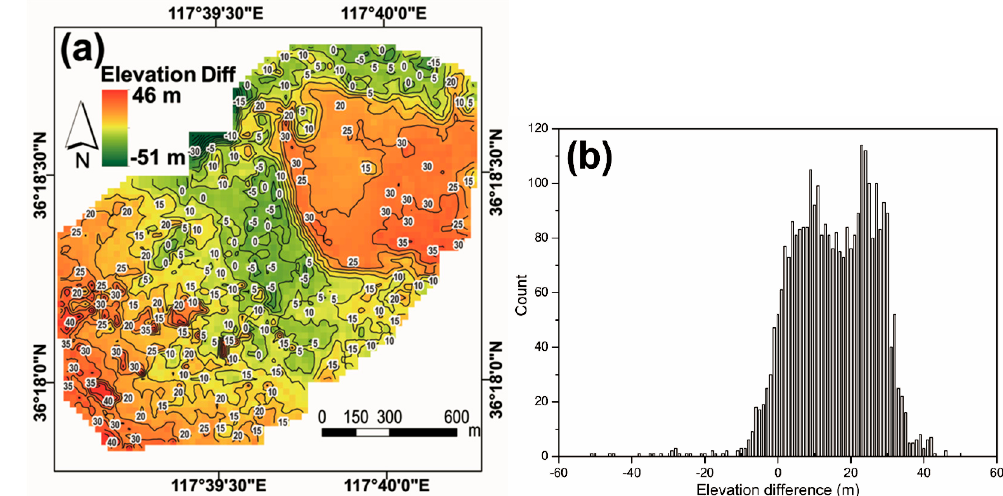
Figure 8. Digital surface models (DSMs) elevation differences ( a ) and distribution ( b ) between the SfM DSM and the AW3D30 DSM.